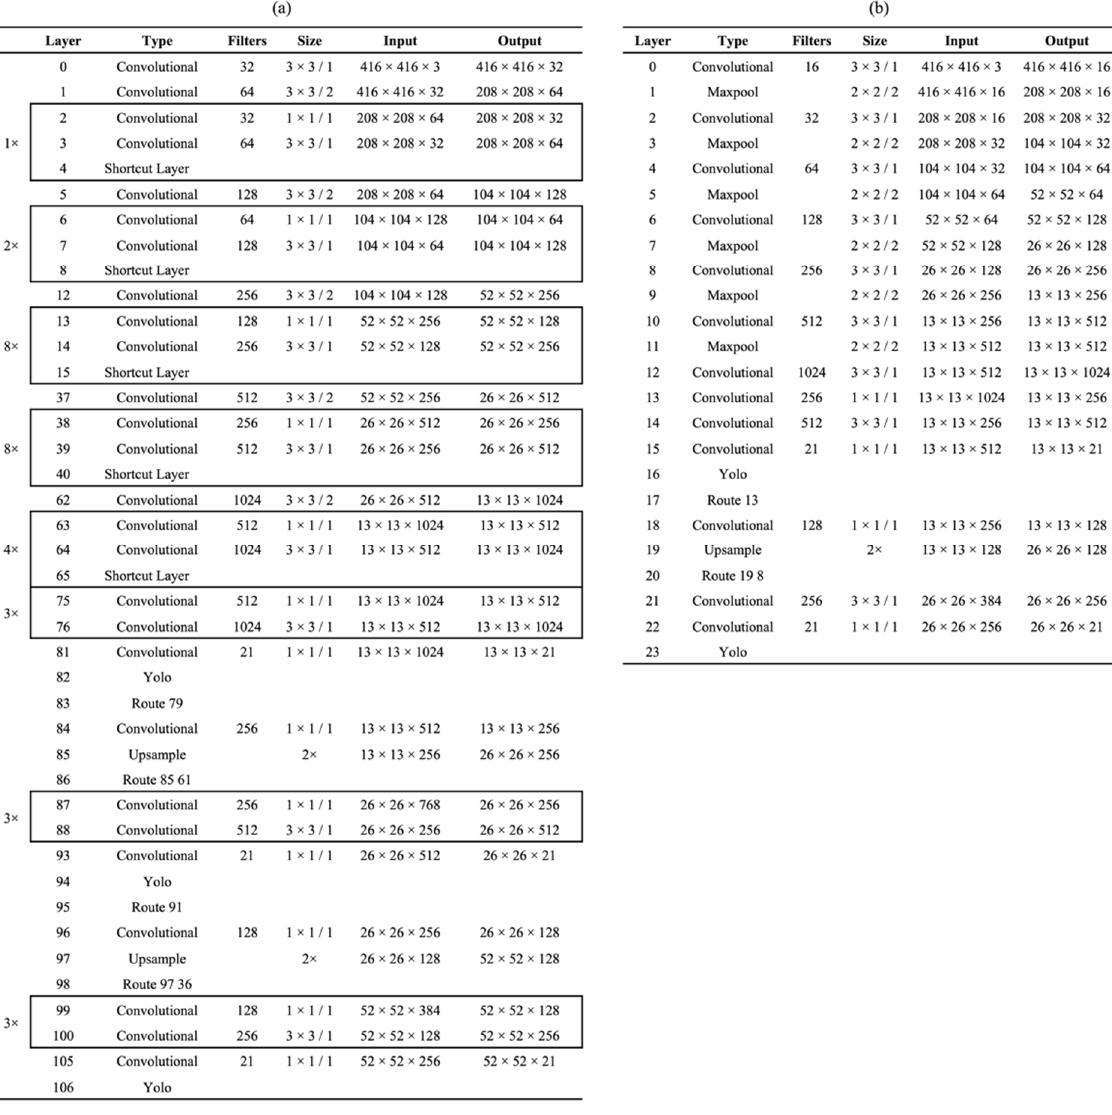
Figure 8. Deep-learning network architecture diagrams. ( a ) YOLOv3 network structure based on Darknet53; ( b ) YOLOv3-Tiny network structure. Darknet53; ( b ) YOLOv3-Tiny network